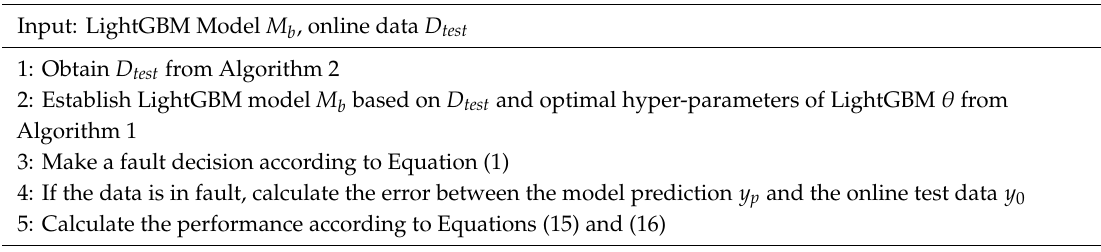
Algorithm 3: Online implementation of improved LightGBM fault detection method